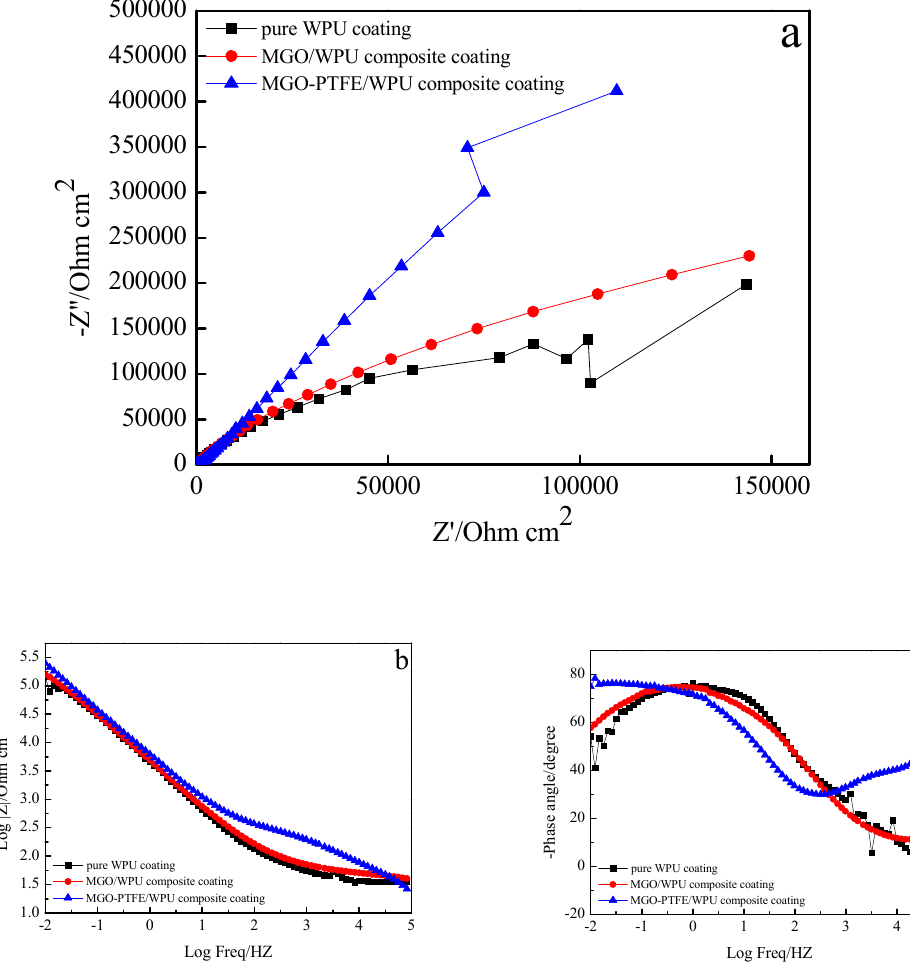
Figure 11. EIS diagrams of pure WPU coating, 1.5 wt.% MGO / WPU composite coating and 1.5 wt.% MGO-PTFE / WPU composite coating after friction, ( a ) Nyquist plot, ( b ) and ( c ) Bode plot.